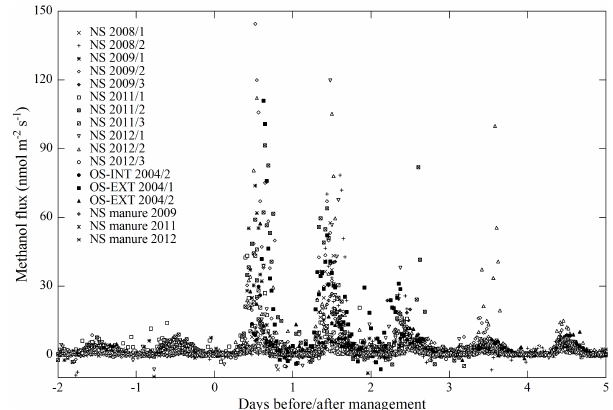
Figure 3. Effect of management (harvest and manure applica- tion) on methanol fluxes of grassland study sites Neustift (NS), Oensingen-INT (OS-INT) and Oensingen-EXT (OS-EXT) within indication of study year and, where applicable, number of